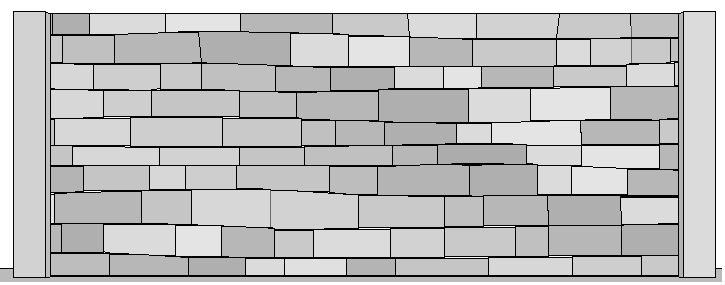
Figure 4. Masonry wall model with irregular coursed structure.